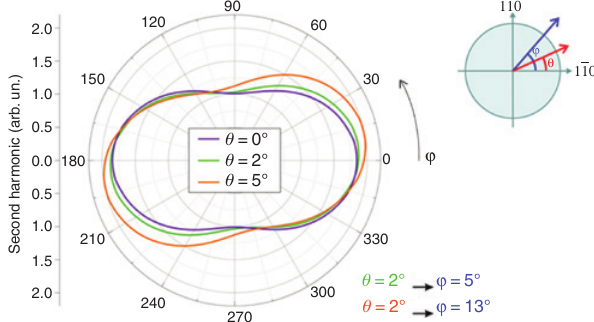
Figure 6: Calculated polarization plots of the emitted SH for a few values of θ (with θ and ϕ defined in the